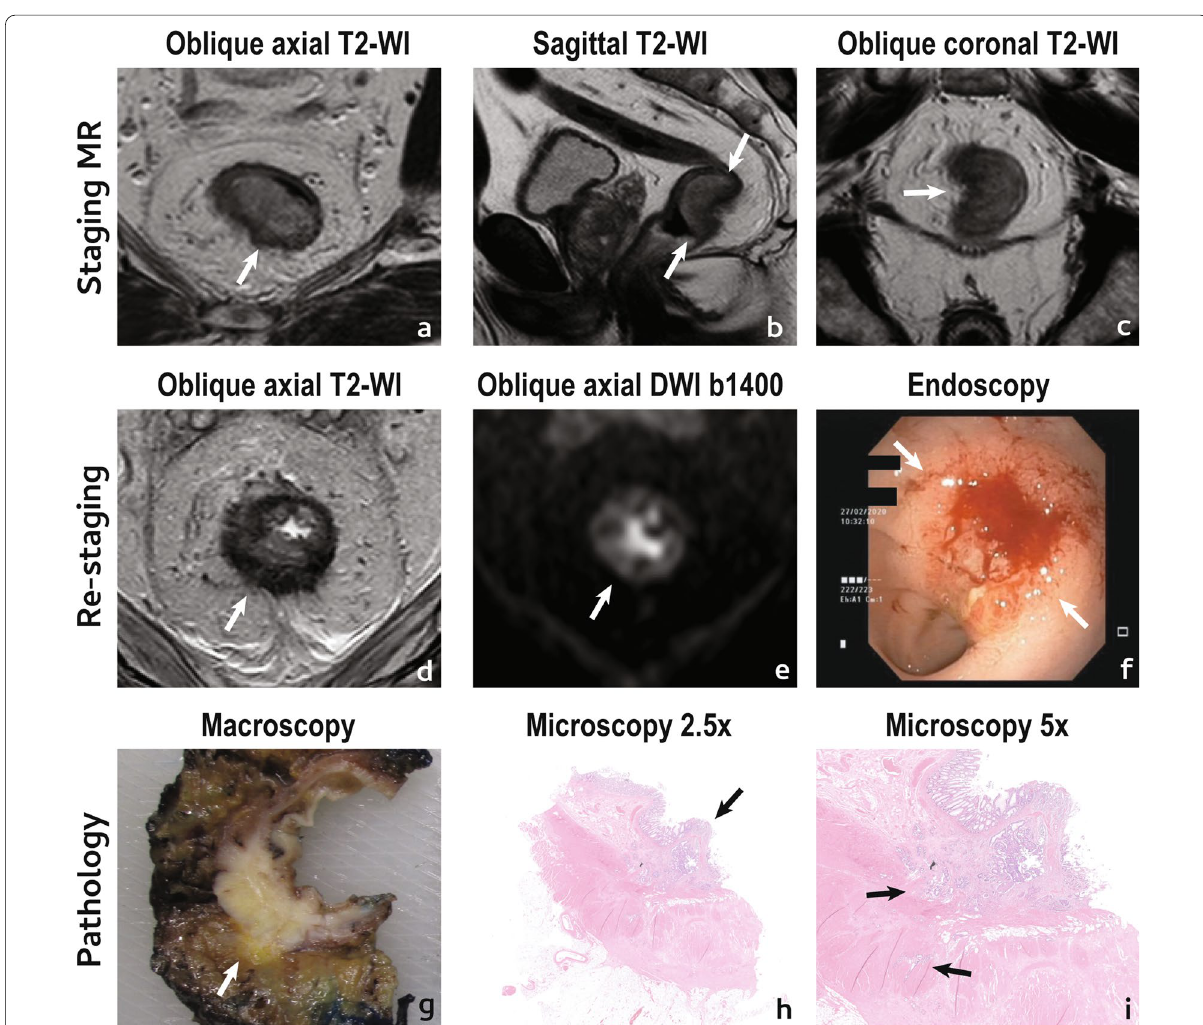
as may be inferred in d vs a . On T2-WI, the tumour scar was composed largely of intermediate signal intensity tissue ( d ), classified as mrTRG4 with absent split scar sign. On high b value DWI ( e ), a thick layer of high signal intensity was apparent at the endoluminal aspect of the tumour